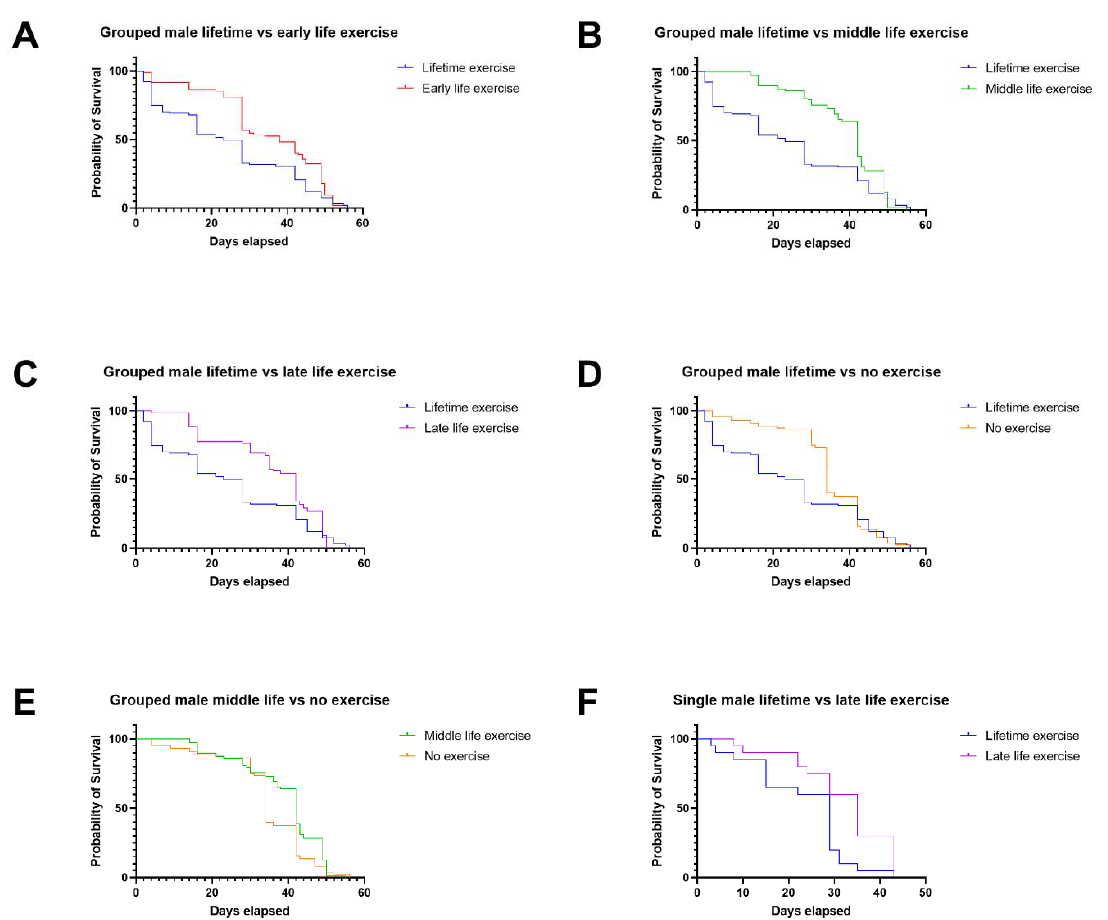
Figure 1. Percentage probability of survival for grouped and single male flies: ( A ) Grouped male flies’ lifetime exercise vs. early-life exercise ( n = 93, 95, respectively) (log-rank test p = 0.0011). ( B ) Grouped male lifetime vs. middle-life exercise ( n = 93, 78, respectively) (log-rank test p = 0.0014). ( C ) Grouped male lifetime vs. late-life exercise ( n = 93, 121, respectively) (log-rank test p = 0.0050). ( D ) Grouped male lifetime vs. no exercise ( n = 93, 87, respectively) (log-rank test p = 0.0237). ( E ) Grouped male middle-life vs. no exercise ( n = 78, 87, respectively) (log-rank test p = 0.0125). ( F ) Single male lifetime vs. late-life exercise ( n = 20, 20, respectively) (log-rank test p = 0.0053).